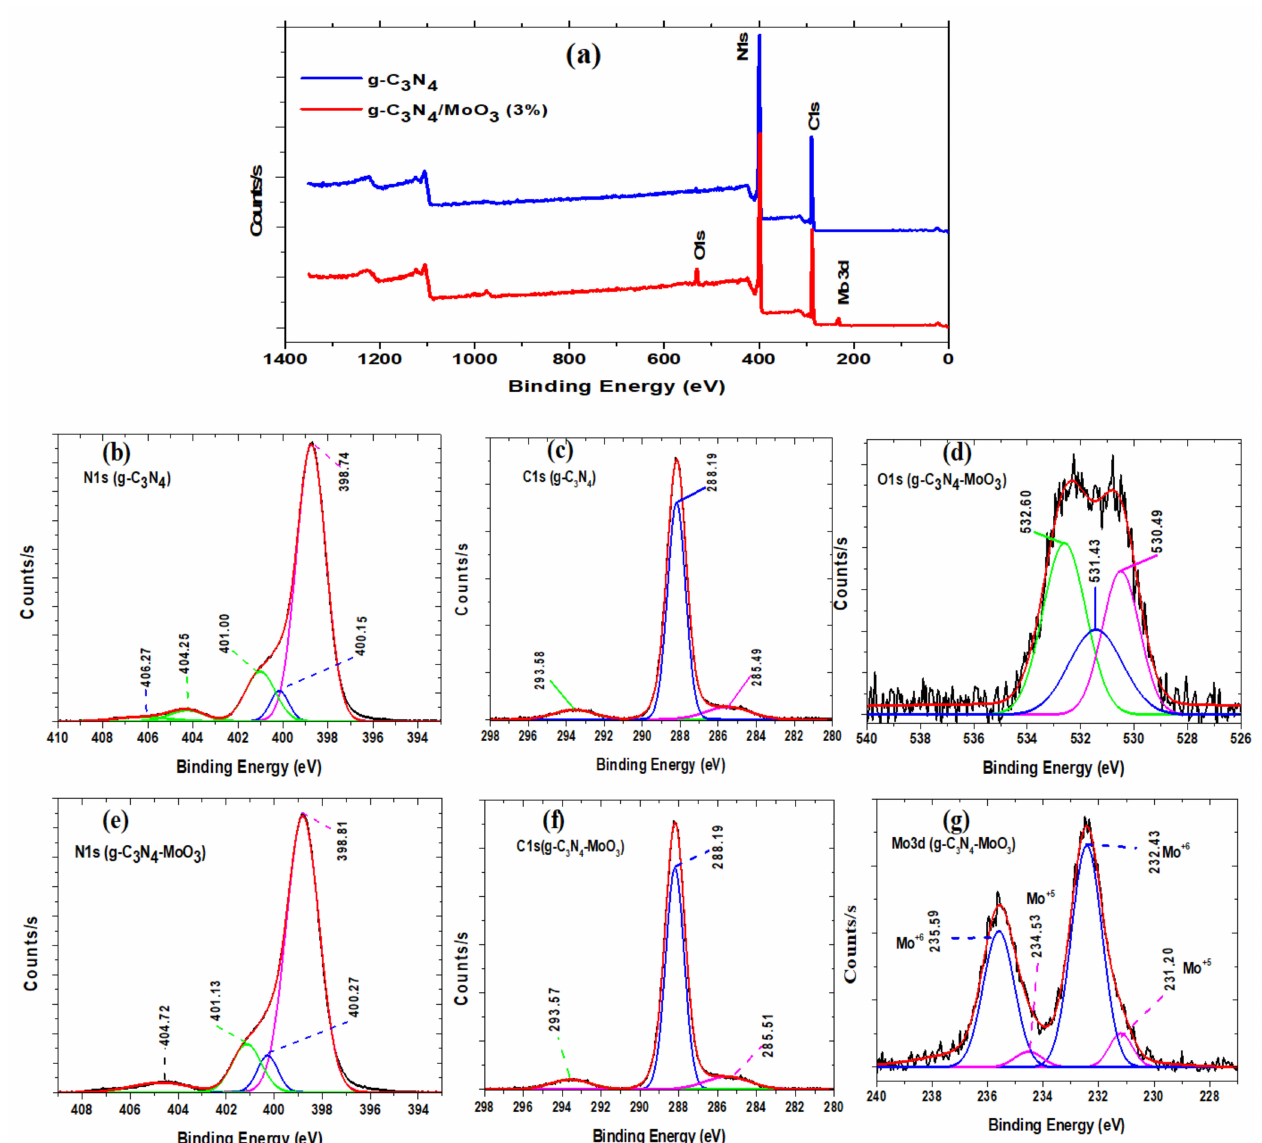
Figure 3. ( a ) XPS scan of gC 3 N 4 and g-C 3 N 4 /MoO 3 (3%) and ( b – g ) resolved XPS for N1s, C1s, O1s and Mo3d. The resolved spectra of O1s for g-C 3 N 4 /MoO 3 (3%) is shown in Figure 3d, comprising of three peaks observed at 530.5, 531.4 and 532.6 eV corresponding to Mo–O, oxygen vacancies and surface hydroxyl groups, respectively [37]; while, the resolved spectra of Mo 3d for g-C 3 N 4 /MoO 3 (3%) showed two types of peaks located at 232.4 and 235.6 eV corresponding to Mo3d 5/2 and Mo3d 3/2 for Mo 6+ in MoO 3 Mo 6+ , while other peaks at 231.2 and 234.5 eV correspond to Mo 5+ [16,38]. The mixed valence states of Mo cations are indicative of surface oxygen vacancies